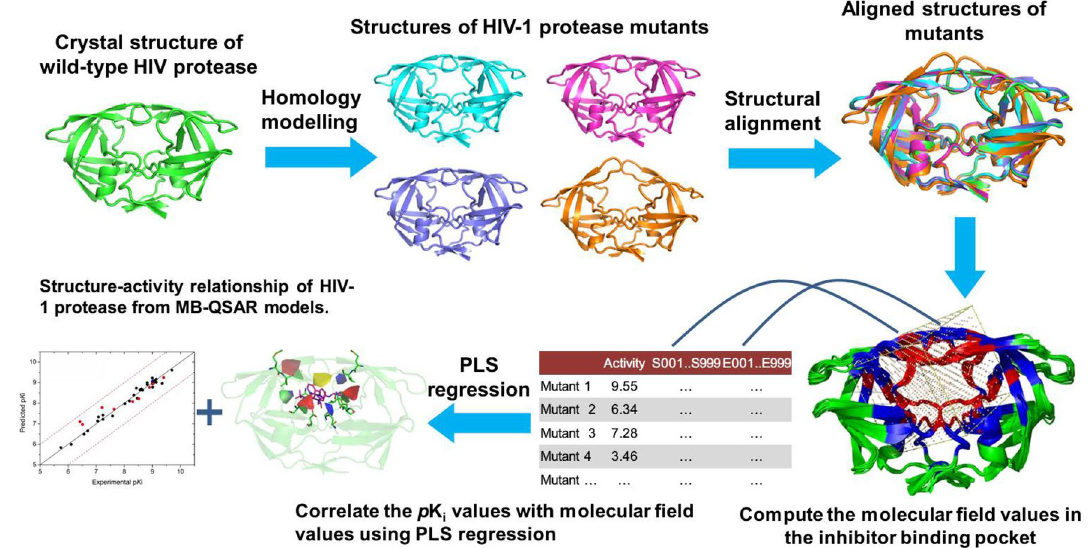
Figure 2. The general flow of MB-QSAR method. The structures of a series HIV-1 PR mutants were constructed and aligned, then the molecular field values in the inhibitor binding pocket were computed using probe atoms. The PLS regression method was used to correlate the p K i values and the calculated molecular field descriptors to achieve the MB-QSAR models. Based on the constructed MB-QSAR models, the molecular drug resistance of HIV-1 PR mutants could be predicted, and interpreting the MB-QSAR models could yield molecular field view for the interaction between the inhibitors and the HIV-1 PR mutants.